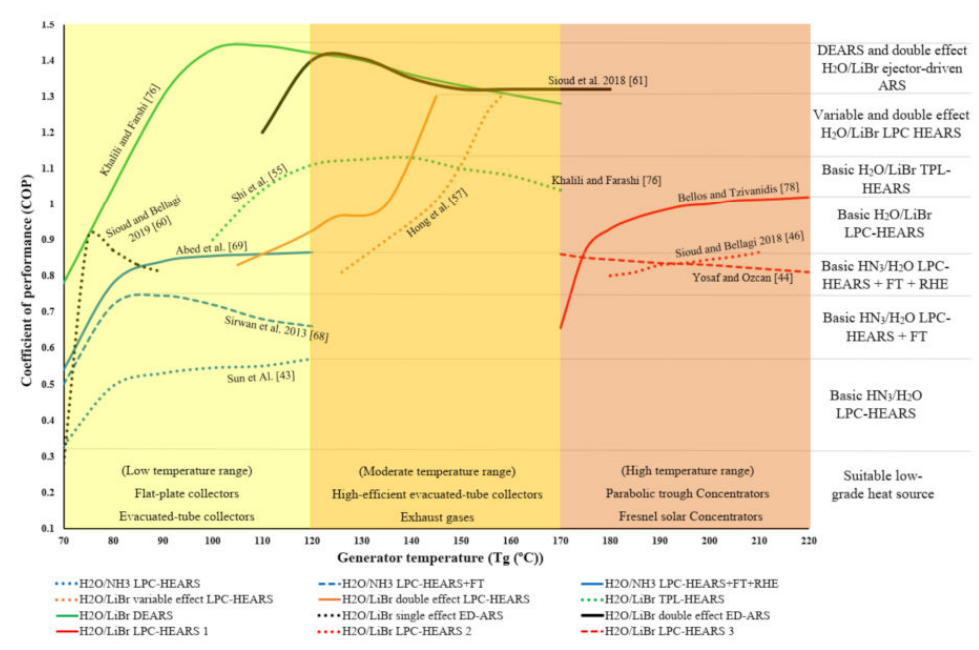
Figure 18. Range of maximum attainable theoretical COP values of various hybrid ejector absorption refrigeration